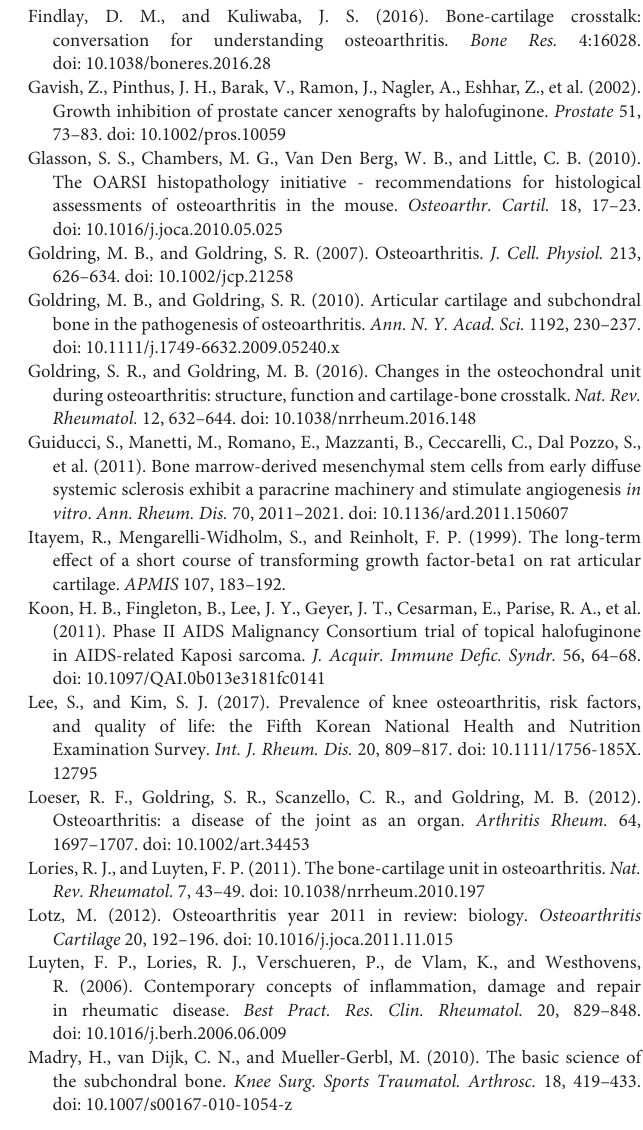
Supplementary Figure 1 | HF, by oral gavage, shows no obvious detrimental effect on the joint after sham operation at 30 d (A) and 60 d (B). Safranin O & Fast Green staining of sagittal sections of tibial medial compartment, where proteoglycan is in red and bone is in blue (top). Scale bar, 500 µ m. H&E staining ( A, bottom, B, bottom), where thickness of HC and CC are marked by double-headed arrows at 1m (A) and 2m (B) after sham surgery. Scale bar, 100 µ m. Changes of HC and CC in thickness among different groups at 1m (C) and 2m (D) after sham surgery. (E) Histologic OA Score of articular cartilage